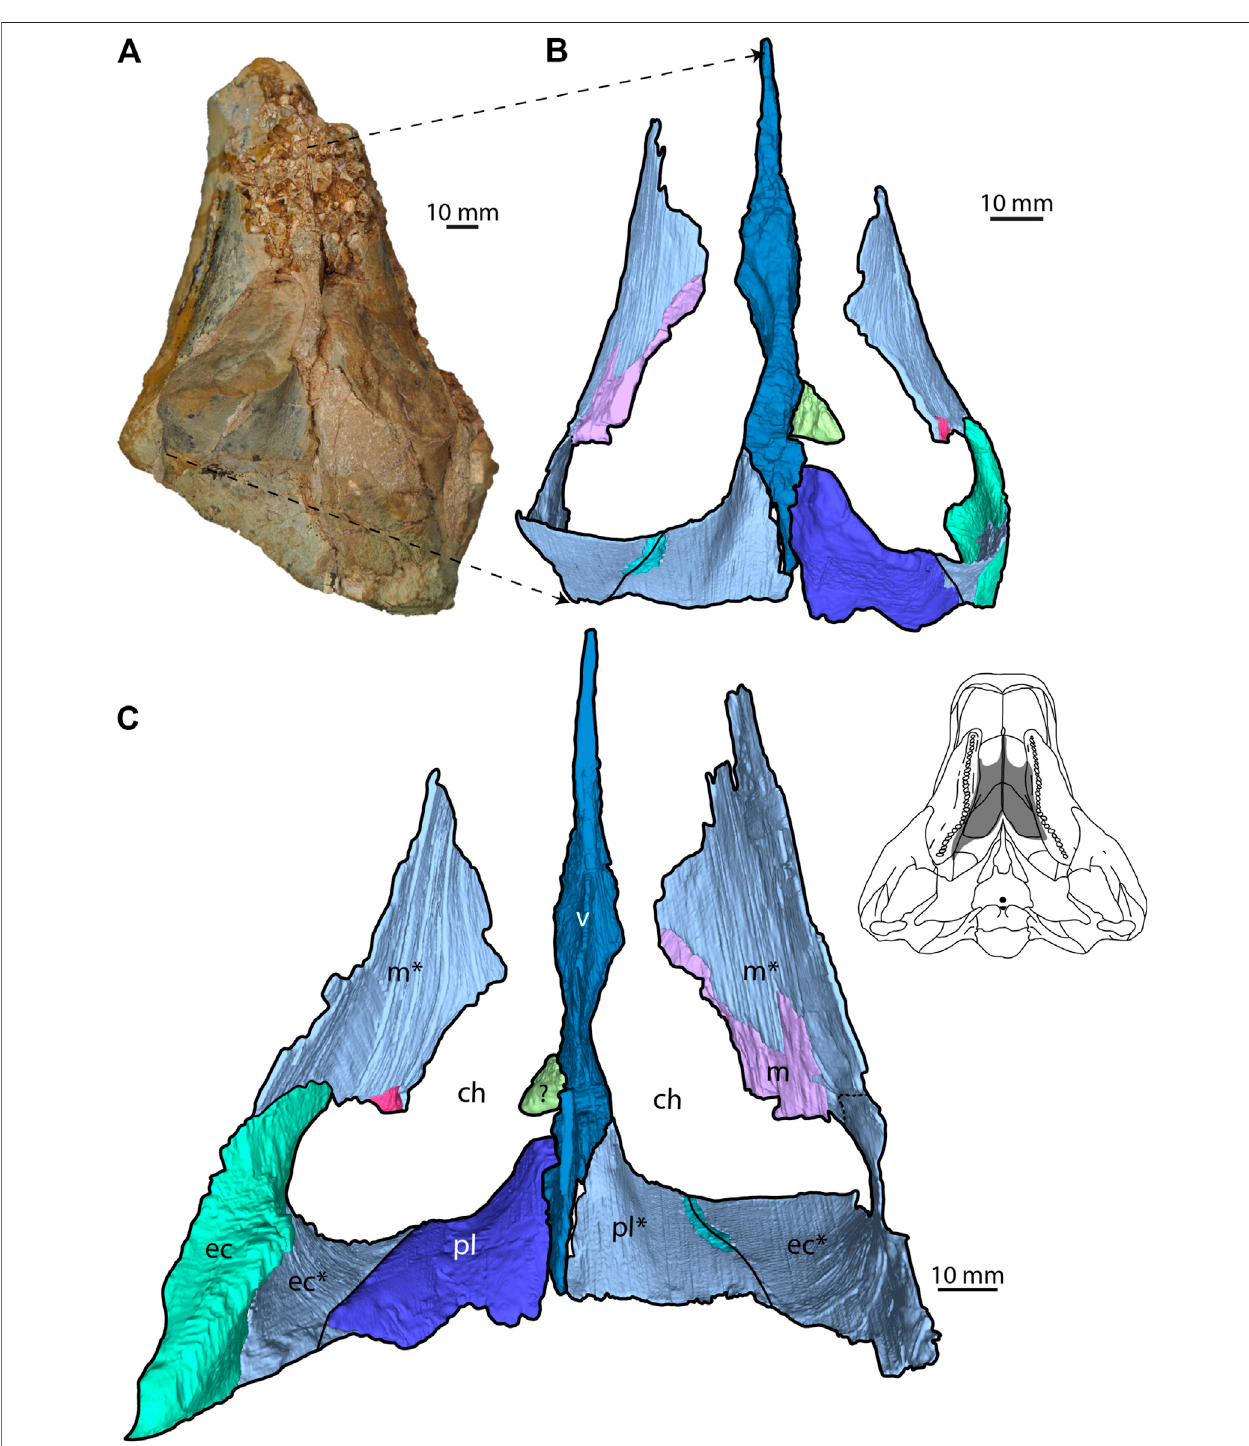
FIGURE 2 | SAMA P40536 palatal region. (A) Dorsal view of the specimen. (B) Dorsal view of the 3D model. (C) Ventral (palatal) view of the 3D model. Skull schematic inset next to C is based on Kunbarrasaurus ieversi (modi fi ed from Leahey et al., 2015) to show the preserved portion of SAMA P40536 (highlighted in grey). Abbreviations: ch, choana; ec, ectopterygoid; m, maxilla pl, palatine; v, vomer. 3D models of bones based on impressions are denoted with an asterisk (*). See Supplementary Material S1 for interactive 3D PDF of SAMA P40536.